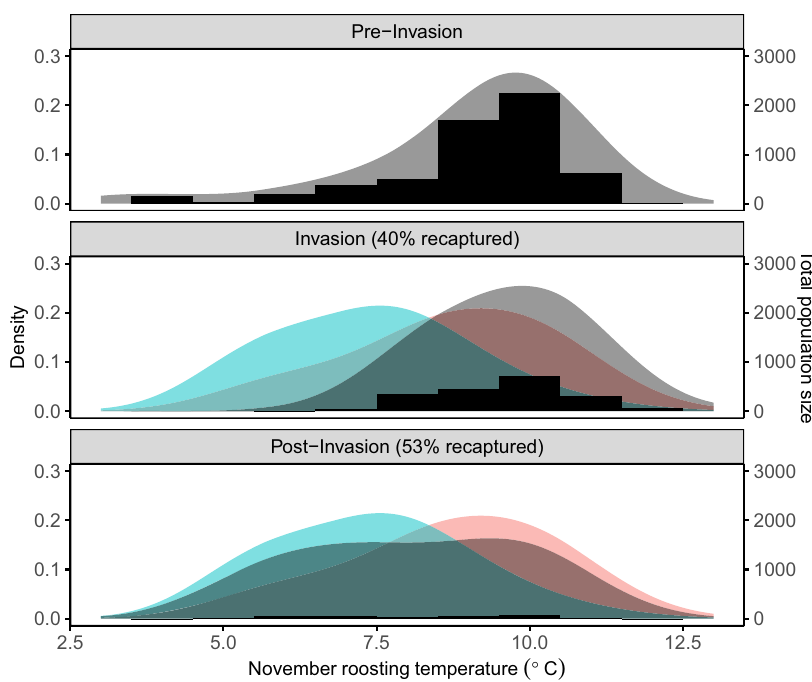
Fig. 6 Changes in bat roosting temperatures during pathogen invasion. The gray density plots (left vertical axis) show the sampled and estimated early hibernation temperature distributions of all counted little brown bats. The blue and red density plots (left vertical axis) show the early hibernation temperature distributions of banded bats that were (blue) and were not (red) recaptured during late hibernation. The gray histogram repeats the gray density plot on the count scale (right vertical axis), to illustrate the large population decline from pre-invasion to post-invasion, especially in warmer microsites. The parentheticals show the increase in banded bat recapture rates across invasion periods (also see Fig. 4a). Overall, the average little brown bat roosting temperature in early hibernation declined ~1 °C from pre-fungal to post-fungal invasion, because the majority of bats roosted in warm microsites where mortality rates were high, whereas a small proportion of the population roosted in cooler microsites with higher recapture